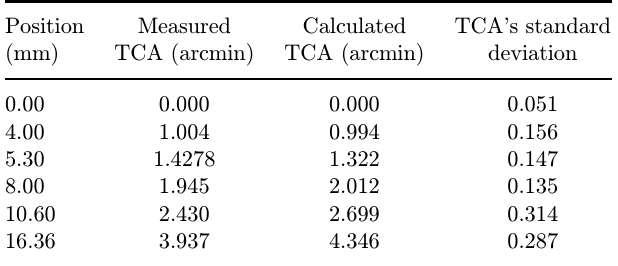
Table 2. Measured and calculated TCA data.